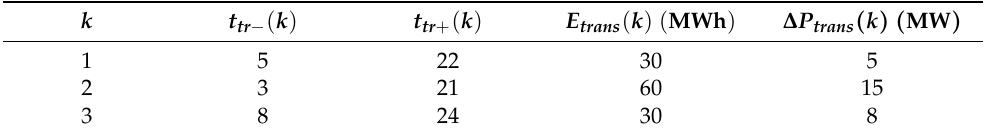
Table 3. Contract data of transferable loads.